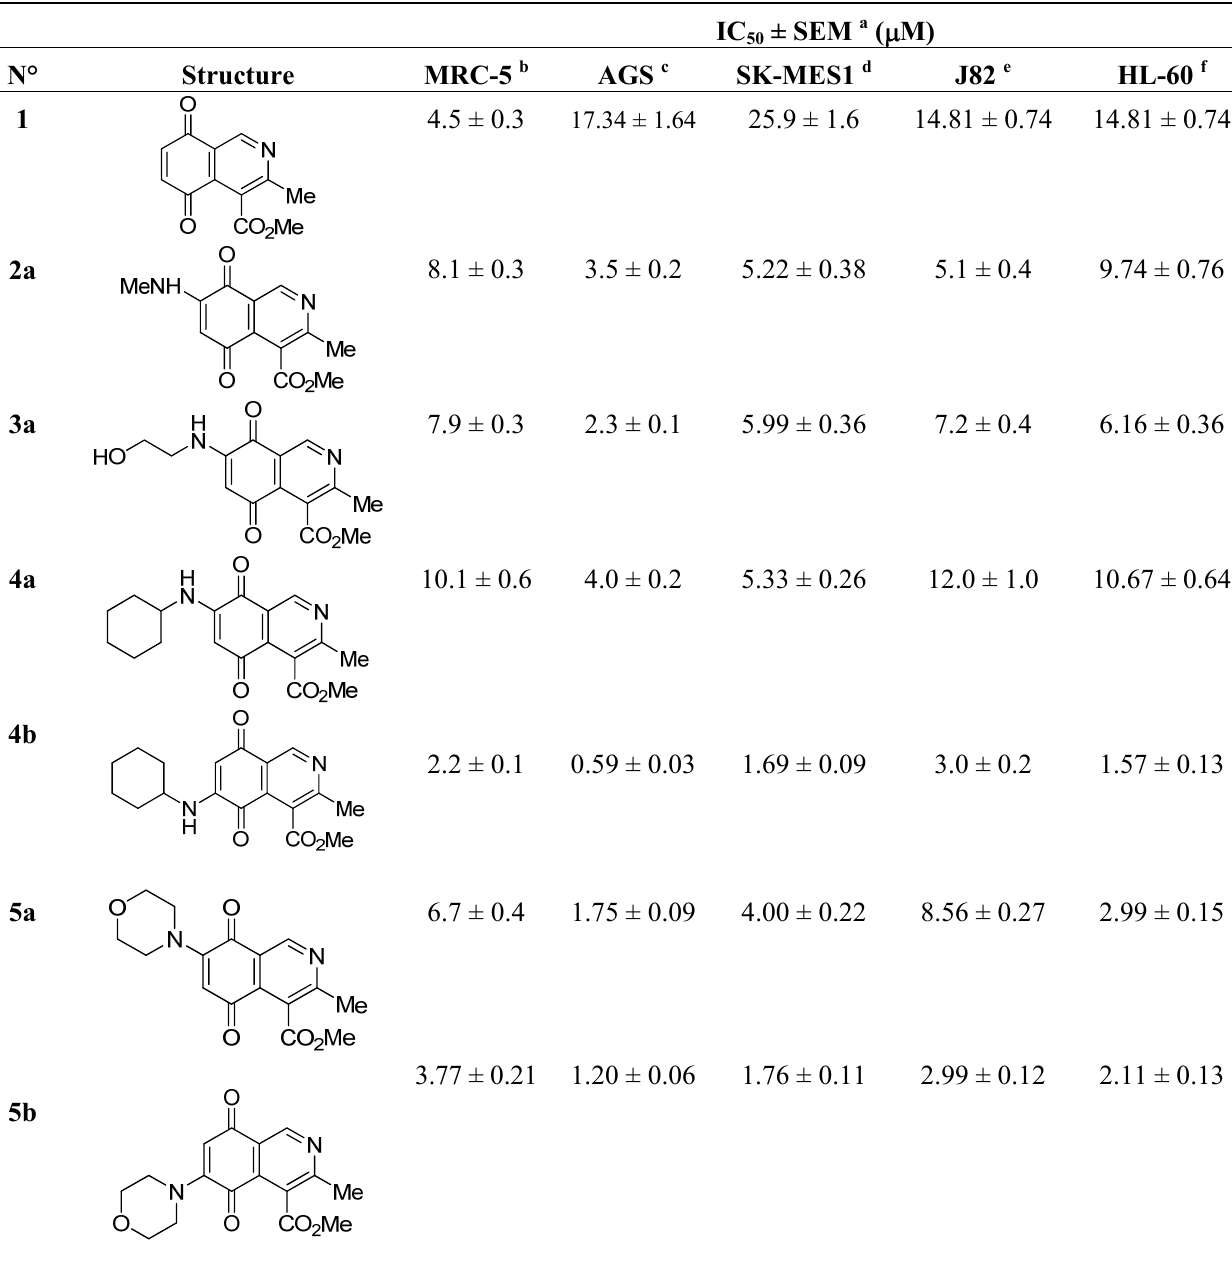
Table 2. Cytotoxic activity of 1 and their aminoisoquinoline-5,8-quinone